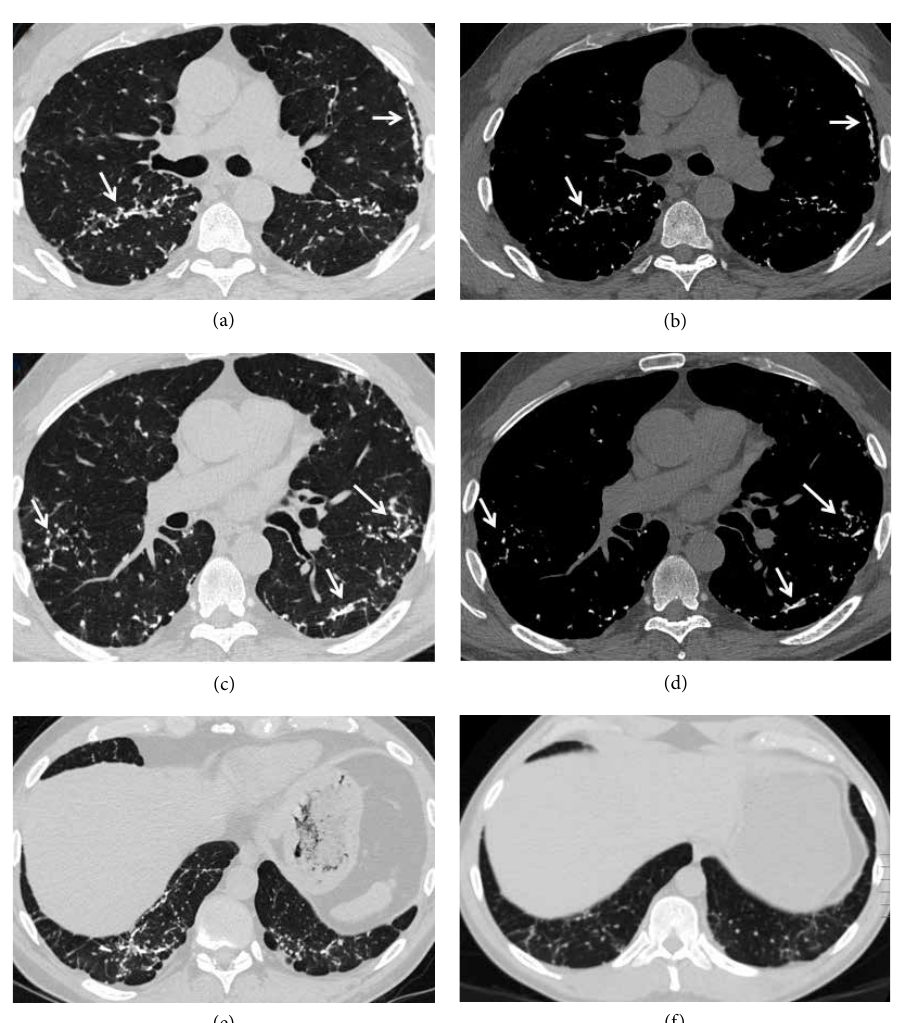
Figure 1: Axial chest CT images using lung (a), (c) and bone (b), (d) windows show bilateral branching dense nodular opacities (arrows) with mild associated reticulation. Some of the nodule are high in attenuation and almost iso-dense to ribs on bone windows. Axial images using lung widow (e), (f) at the level of lung bases were obtained 5 years apart and show evidence of progression.